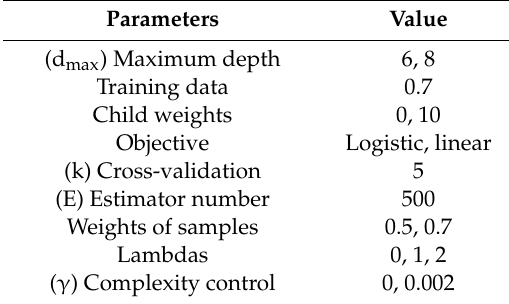
Table 2. Hyperparameters.